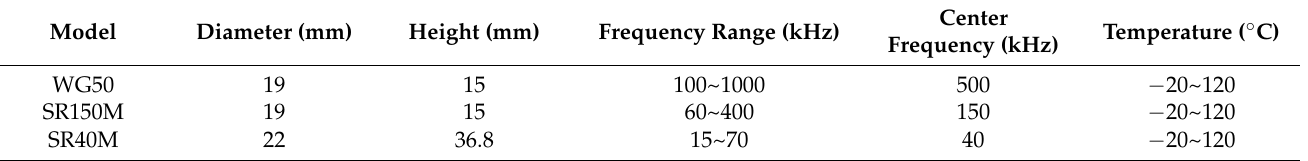
Figure 1. Tensile testbed of steel strand. Figure 2. Prefabricate a notch on the steel strand.